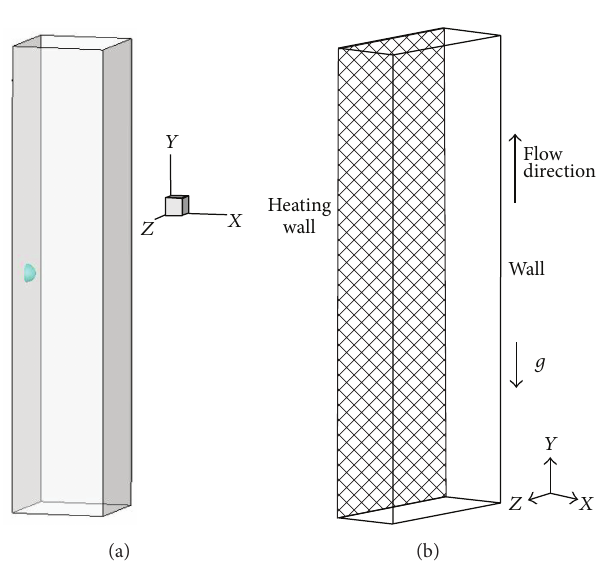
Figure 3: Schematic of the mesh